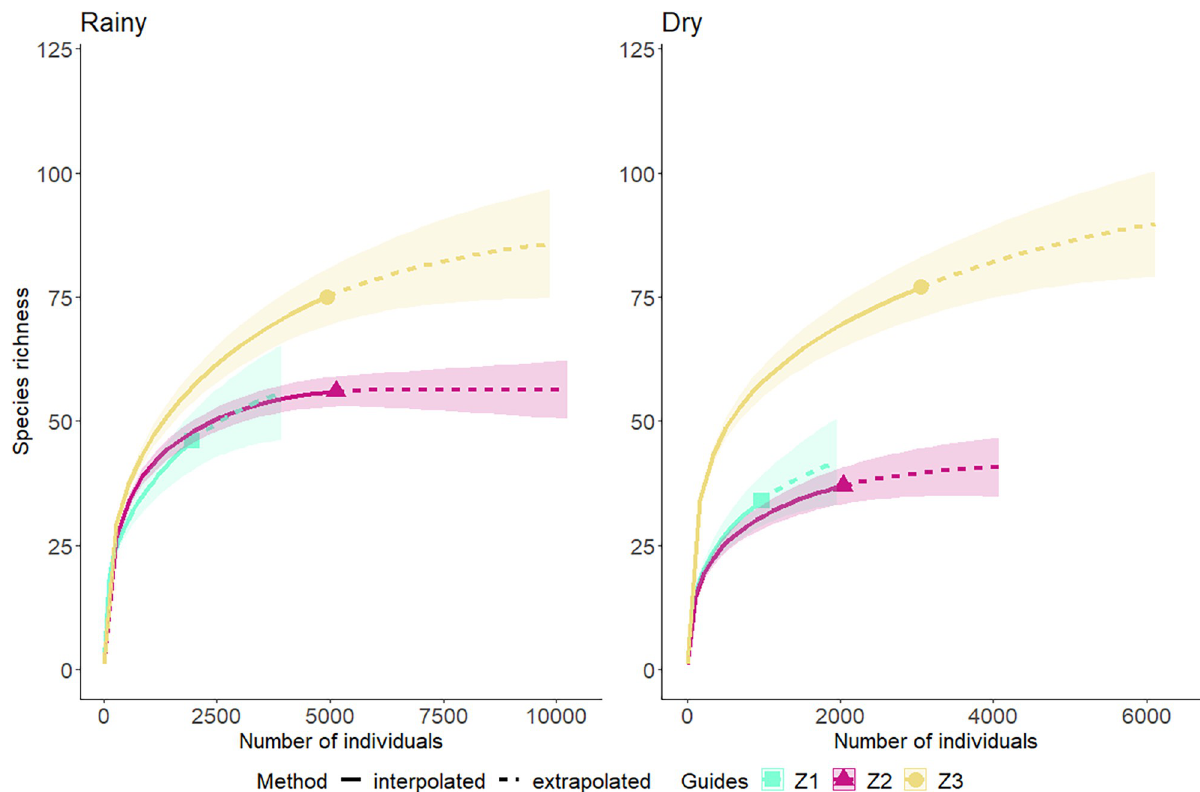
Fig 1. Species rarefaction curves with interpolation and extrapolation of fish assemblages by three zones during 2015/2016 rainy and dry seasons in Mamanguape River